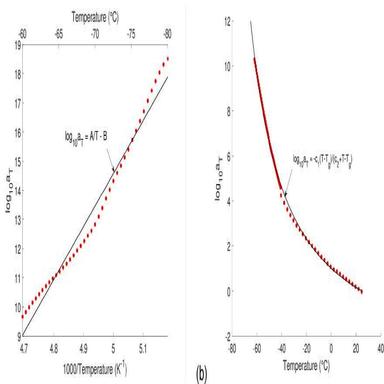
Shift factors used to construct the master curve for U-NR follow an (a) Arrhenius form below Tg and (b) WLF form above Tg.